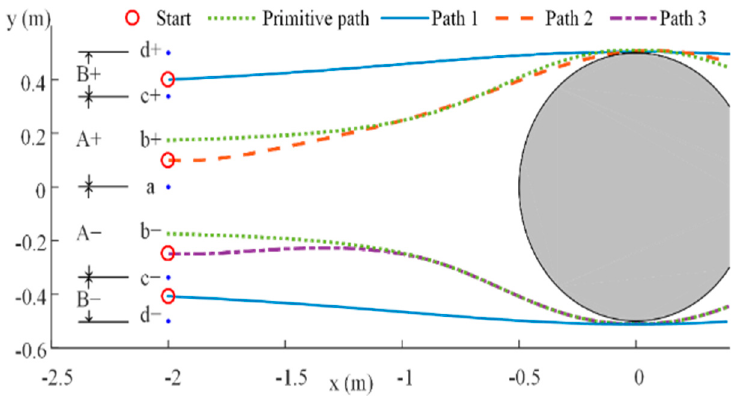
Figure 10. The illustration of the primitive path selecting strategy. The range [ − r obs , r obs ] according to the obstacle size is partitioned manually into three intervals from far to near to reflect the reaction distance. Robots with different lateral displacements related to an obstacle will pursue different primitive streamline paths aligned with the current robot heading. Path 1 and Path 2 tangentially traverse the enlarged circular obstacle